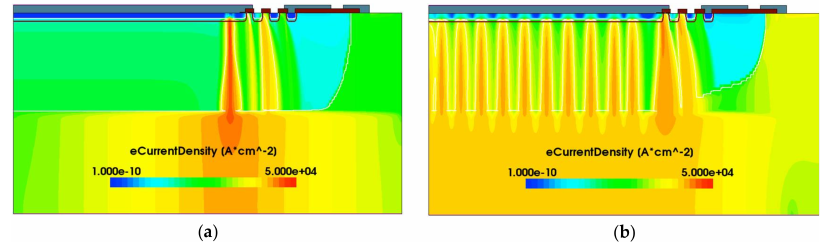
Figure 12. Electron current density distribution at t = t 1 in the: ( a ) DEV1 structure; and the ( b ) DEV2 structure.